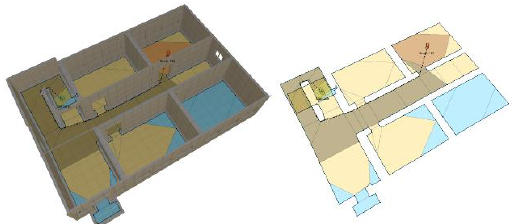
Figure 13 Indoor path planning from “Room 102” to